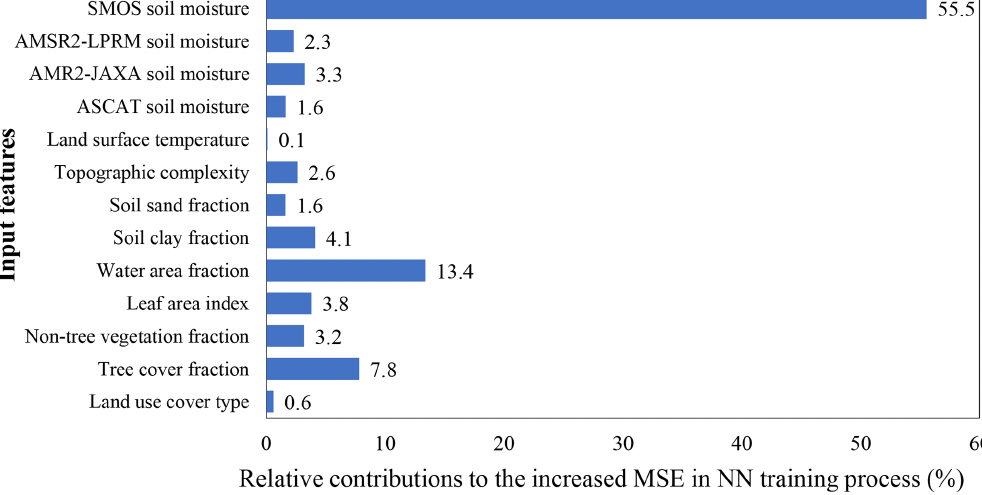
Figure 16. Relative contributions of the 13 input features (i.e. four predictor soil moisture products retrieved from microwave remote sensing and nine environmental factors that are quality impact factors of microwave soil moisture retrieval or also indicators of soil moisture) to the training efficiency of the first round’s primary neural network